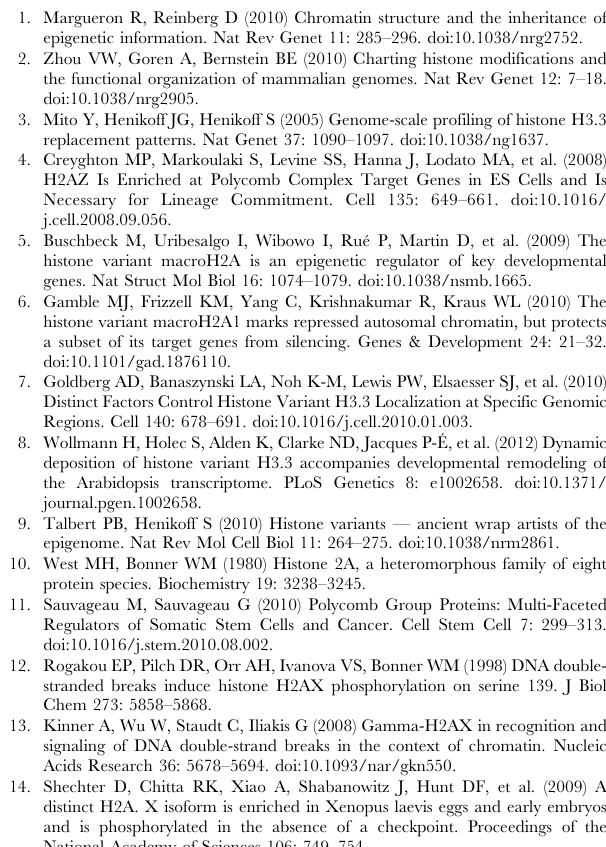
Figure S6 Classification of genes according to expres- sion level. The expression level of coding genes was obtained from the RNA sequence data. The histogram of gene expression levels was smoothed by kernel density estimation. The genes were classified into six groups according to their expression levels. Groups 1, 2, 3, 4, 5 and 6 contained 6728, 447, 1161, 2526, 2760 and 1009 genes, respectively. Figure S7 Correlation between the expression level and enrichment of histone variants in gene promoters. Genes were classified into six groups according to their expression levels as shown in Figure S6, and the enrichment of histone variants and histone modifications in the promoters (TSS 6 2 kb) of genes in each group are shown as box plots. The bottom and top of the box are the 25th and 75th percentile, respectively, and the upper and lower whiskers represent 2.5th and 97.5th percentile, respectively. Figure S8 Correlation between the expression level and enrichment of histone variants in gene bodies. Genes were classified into six groups according to their expression levels as shown in Figure S6, and the enrichment of histone variants and histone modifications in the gene body (TSS + 2 kb , TES) in each group are shown as box plots. Figure S9 Enrichment of histone variants in the pro- moters of HCP and LCP genes. Genes were classified into HCP & active, HCP & inactive, LCP & active, and LCP & inactive on the basis of CpG density at the promoter and gene